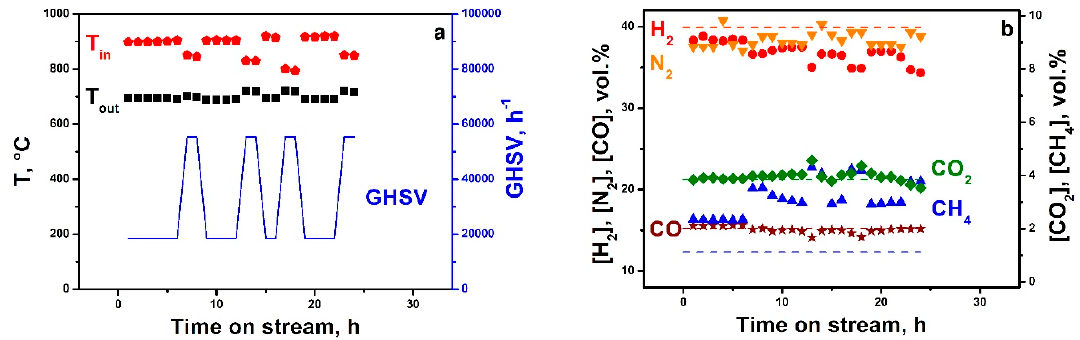
Figure 3. The inlet (T in ) and outlet (T out ) temperatures of the Rh-block and space velocity ( a ); H 2 , N 2 , CO, CO 2 , and CH 4 concentrations ( b ) (on a dry basis) as a function of time on stream for PO of methane-rich syngas. Experimental conditions: GHSV 18,000–55,000 h − 1 , 1 bar pressure, reactor wall temperature 730 °C, reaction mixture (vol.%): 25.6 CH 4 , 13.4 O 2 , 10.5 H 2 O, and 50.5 N 2 . Points are experimental. Dashed lines are equilibrium concentrations.